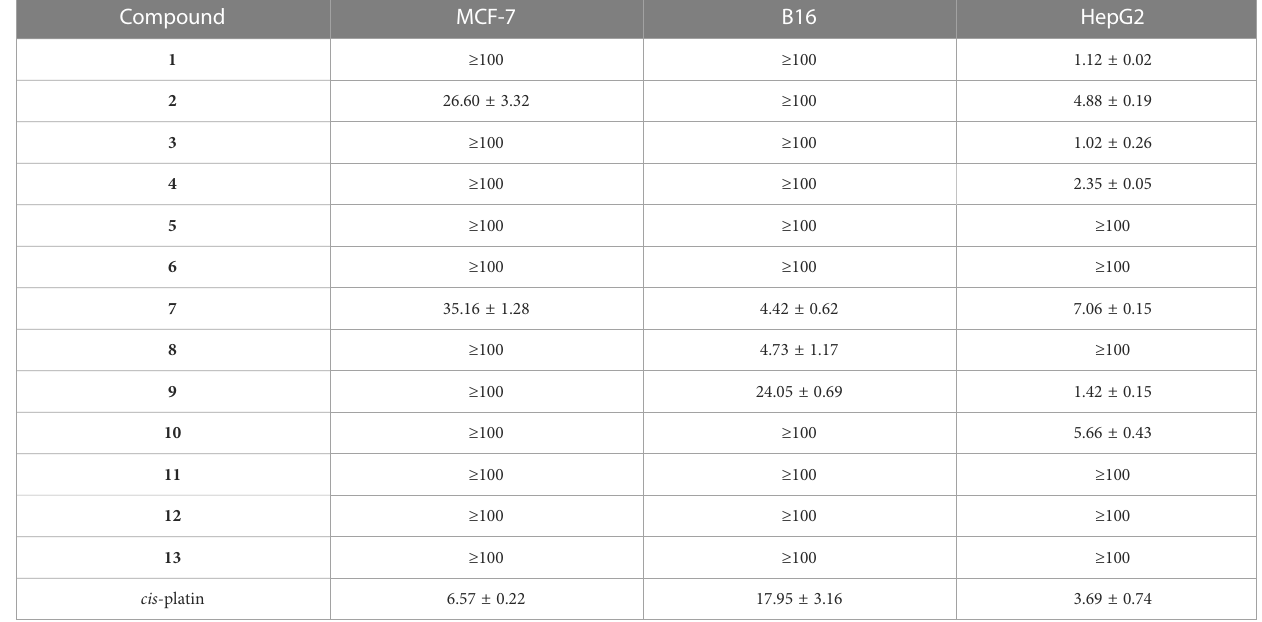
TABLE 3 Cytotoxicity (IC 50 , m M) of compounds 1 − 13 against cancer cell